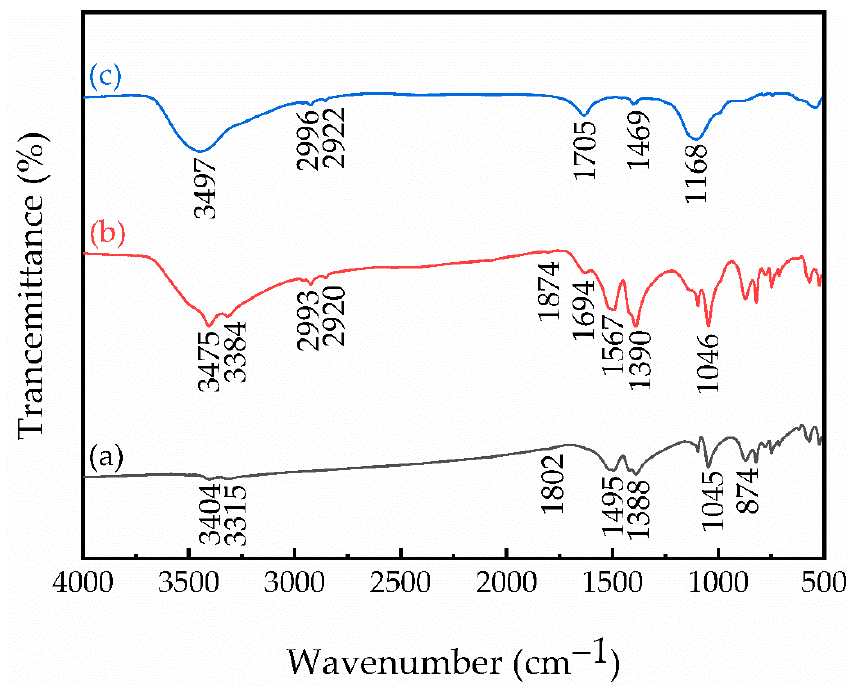
Figure 5. FTIR spectra as follows: ( a ) pure malachite, ( b ) malachite + Na 2 S and ( c ) malachite + (NH 4 ) 2 S, Na 2 S = 6 × 10 − 2 mol/L, (NH 4 ) 2 S = 6 × 10 − 2 mol/L. (NH × 10 − 2 mol/L, (NH × 10 − 2 4 ) 2 S, Na 2 S = 6 4 ) 2 S = 6